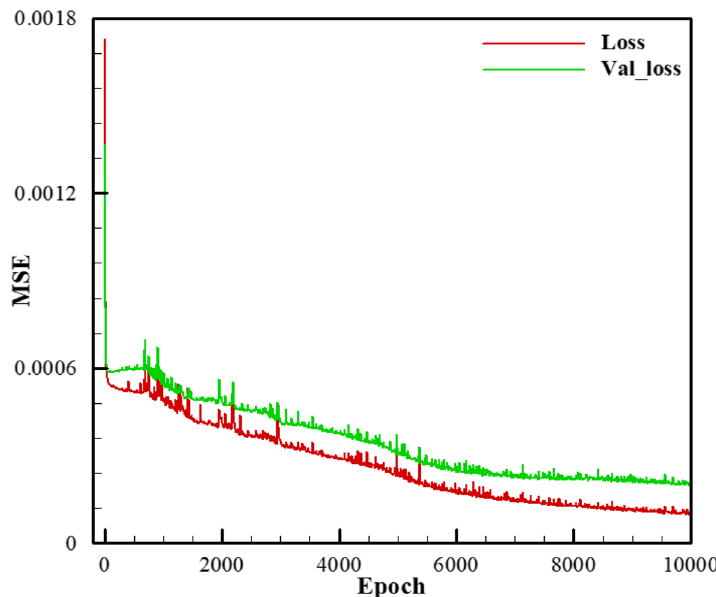
Fig. 15 Mean squared error of training set and validation